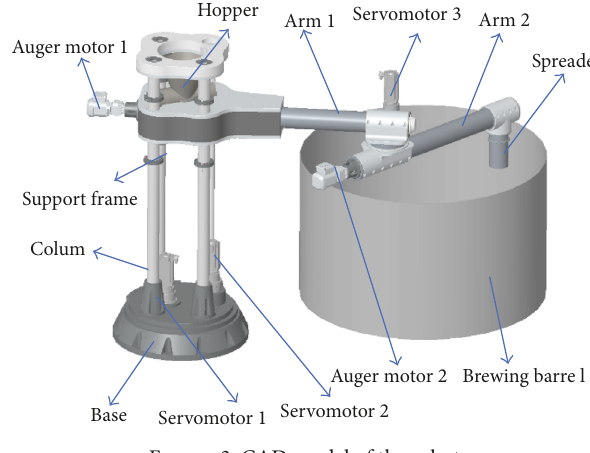
Figure 3: CAD model of the robot.